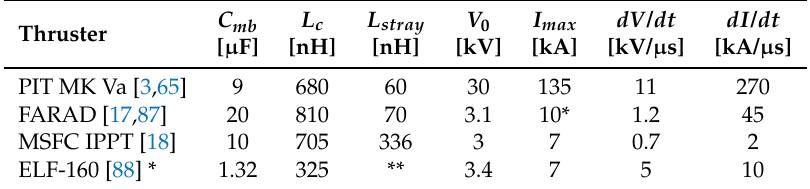
Table 2. Representative circuit parameters for selected IPPTs. (* estimated values, ** value not reported).